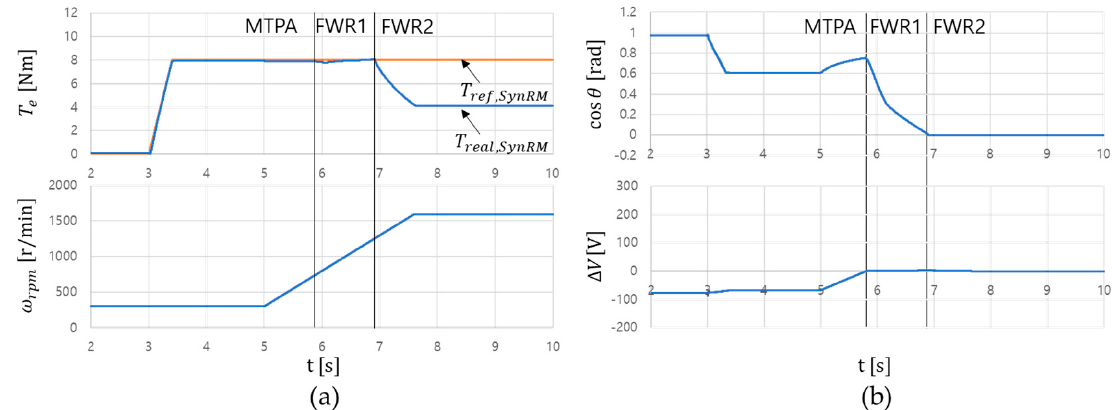
Figure 10. Simulation results with the dynamic inductance of the cross-coupled flux saturation model: ( a ) simulation conditions and ( b ) operation of the proposed algorithm.